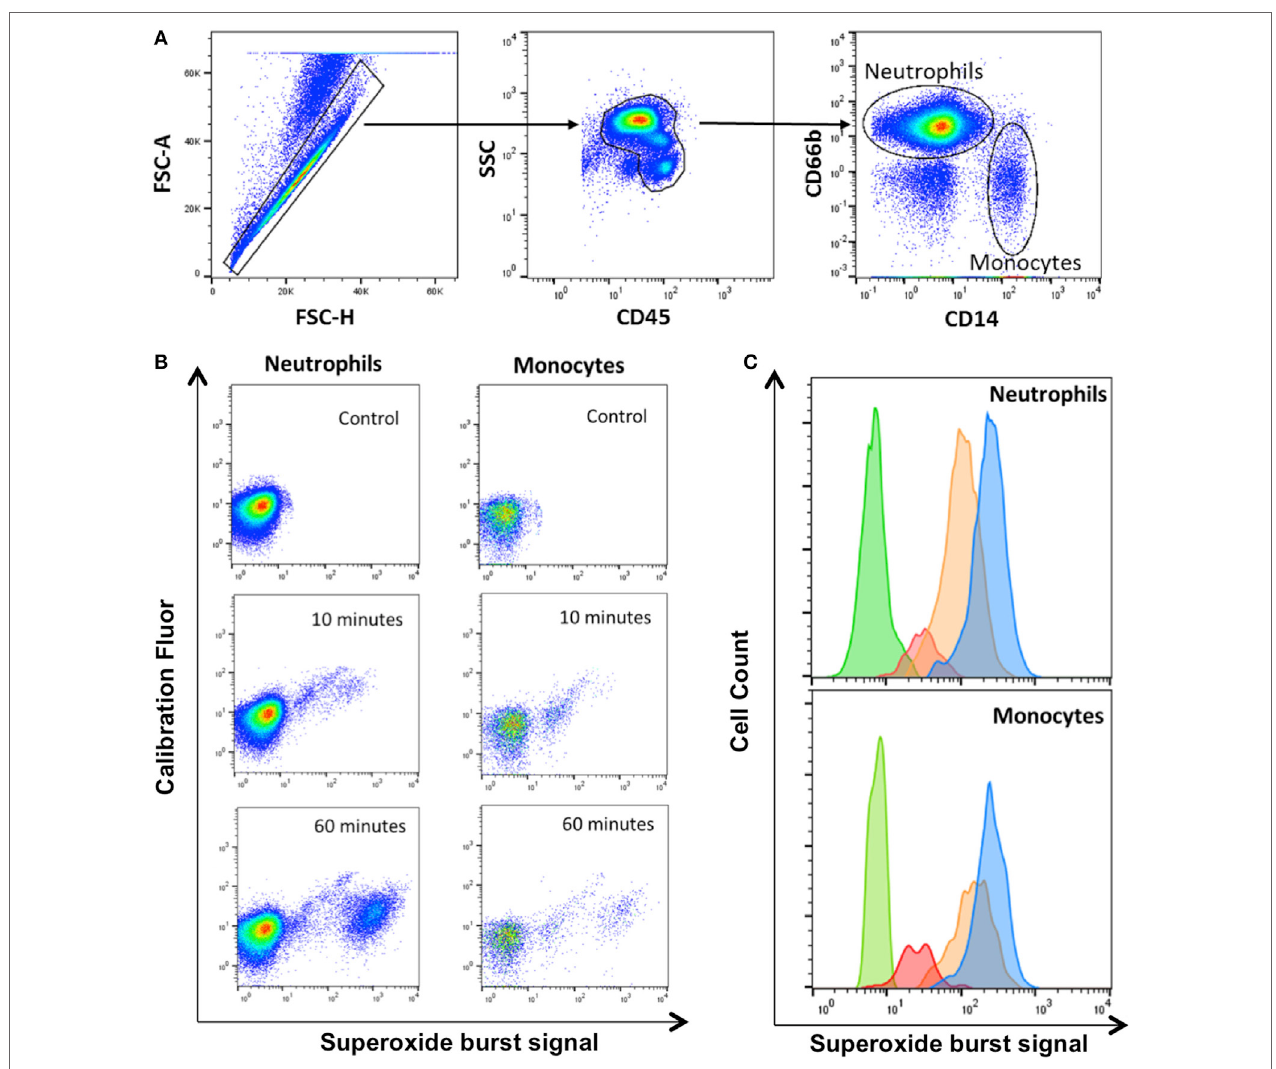
FIGURe 1 | Gating strategy for identification of phagocytes with zymosan reporter particles and quantitation of intraphagosomal oxidation. (A) Gating strategy displaying forward scatter (FSC), side scatter (SSC), CD45 PerCP, CD66b APC, and CD14 PE-Cy7 to identify neutrophils and monocytes. The gating strategy illustrated is from one representative healthy volunteer. (B) Zymosan-induced superoxide burst activity in neutrophils and monocytes in a healthy control. The OxyBURST fluorescence increases after intraphagosomal oxidation of the zymosan-reporter particles (Alexa Fluor 405-labeled) after 10 and 60 min compared with control sample with no zymosan-reporter particles. (C) Overlay histogram demonstrating the shift in fluorescence of cells with zymosan reporter particles due to oxidation after 10 min (red), 30 min (orange), and 60 min (blue) compared with cells without zymosan-reporter particles (green) for both neutrophils and